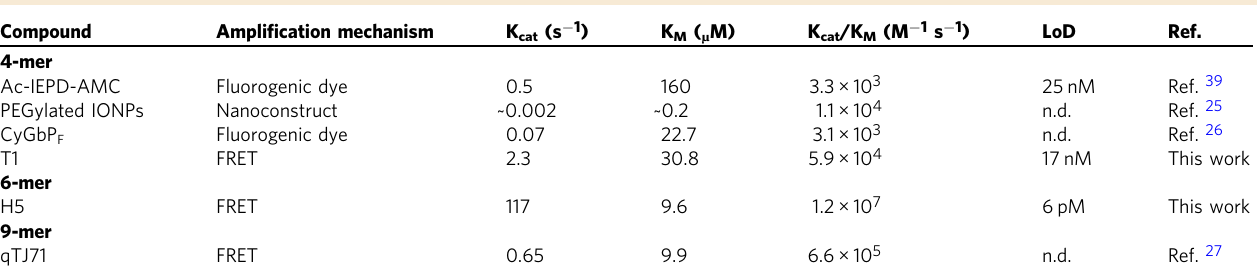
Table 1 Summary of fl uorescent peptide-based probes for GzmB.